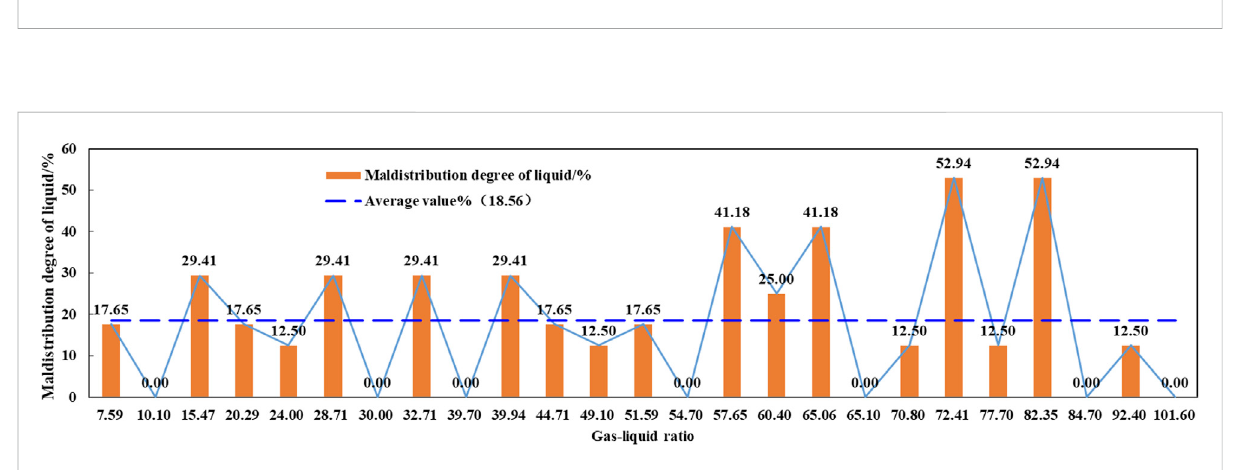
FIGURE 6 Histogram of gas – liquid ratio and maldistribution degree of liquid in strati fi ed fl ow in horizontal manifold with fl ute pipes (liquid injection volume 0.10L/s+0.17L/s).